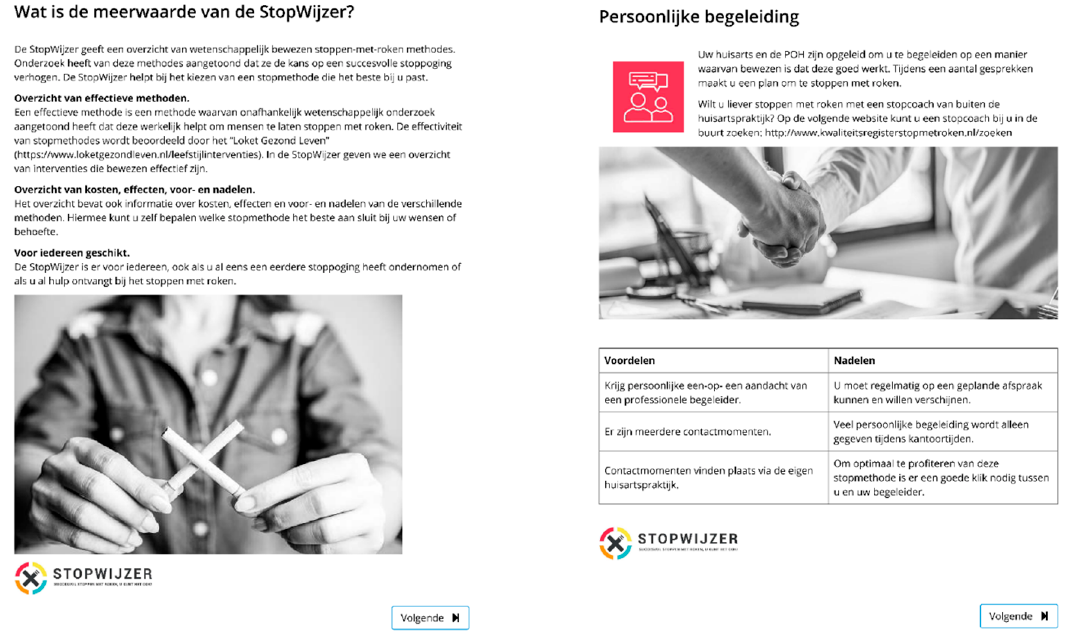
Figure 1. Excerpts from the DA website. Figure 1. Decision overview (option